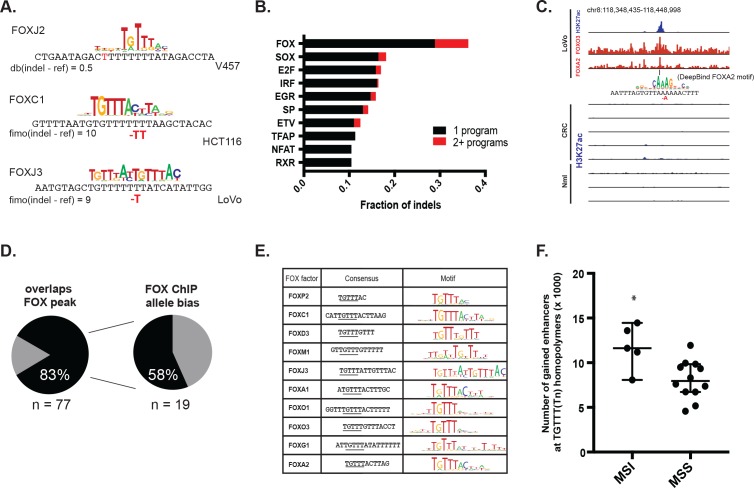
MSI enhancer indels recruit FOX factors.(A) Examples of FOX motifs at MSI indels, with change in affinity scores. (B) Fraction of indels predicted to increase transcription factor affinity by TF family, supported by one (black) or multiple (red) computational programs. (Figure 4—source data 1). (C) Genome Browser snapshot of MSI enhancer indel overlapping FOXA2 and FOXO3 peaks in LoVo cells. Motif of FOXA2 generated by DeepBind, which predicts increased binding of FOXA2 to the indel alelle, is shown. (D) (left) Fraction of LoVo enhancer indels overlapping a FOX factor peak. (right) Fraction of indels in FOX factor peaks and with >3 FOX ChIP read coverage showing allele-bias. (E) Motifs of FOX factors expressed in MSI lines and predicted to bind preferentially to indel alleles. (F) Number of gained enhancers at TGTTT(Tn) motif in MSI versus MSS lines. *p<0.05, Wilcox ranksum test.10.7554/eLife.40760.015Figure 4—source data 1.Transcription factors predicted to bind more favorably to enhancer indels, based on three computational programs.